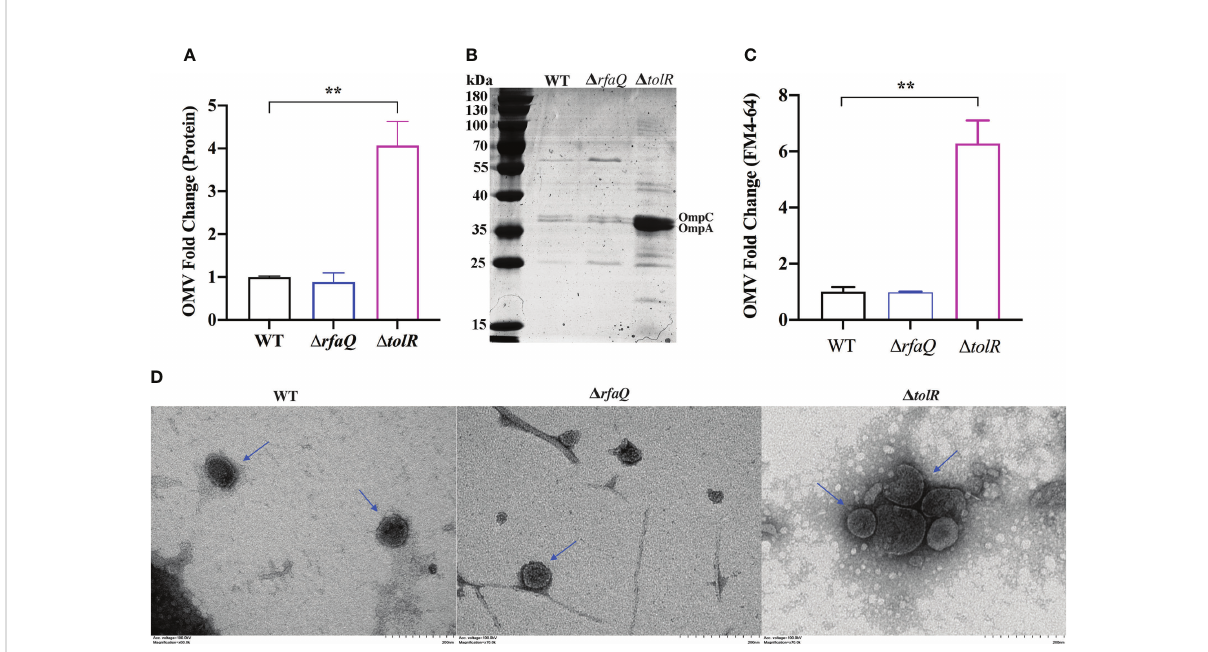
FIGURE 1 Comparison of OMV production by the three S. Enteritidis strains. (A) The relative fold of OMV production by the S. Enteritidis D rfaQ and D tolR strains was calculated and compared with that of the WT strain (normalized to 1) by measuring OMV protein concentrations. (B) SDS-PAGE of 10 m l OMVs extracted from WT, D rfaQ , and D tolR strains. (C) Measurement of OMV production by the WT, D rfaQ , and D tolR strains using the fl uorescent dye FM4-64 to determine the OMV lipid concentrations. The lipid concentrations in OMVs from the WT strain were normalized to 1. (D) Determination of the size of OMVs from WT, D rfaQ and D tolR strains using TEM analysis. Scale bar = 200 nm. The protein and LPS measurements of OMVs were performed in triplicate and are shown as mean ± SEM. ** p ≤